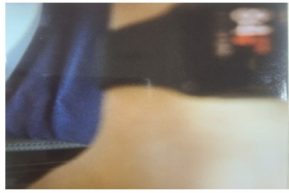
Figure 13. Smart